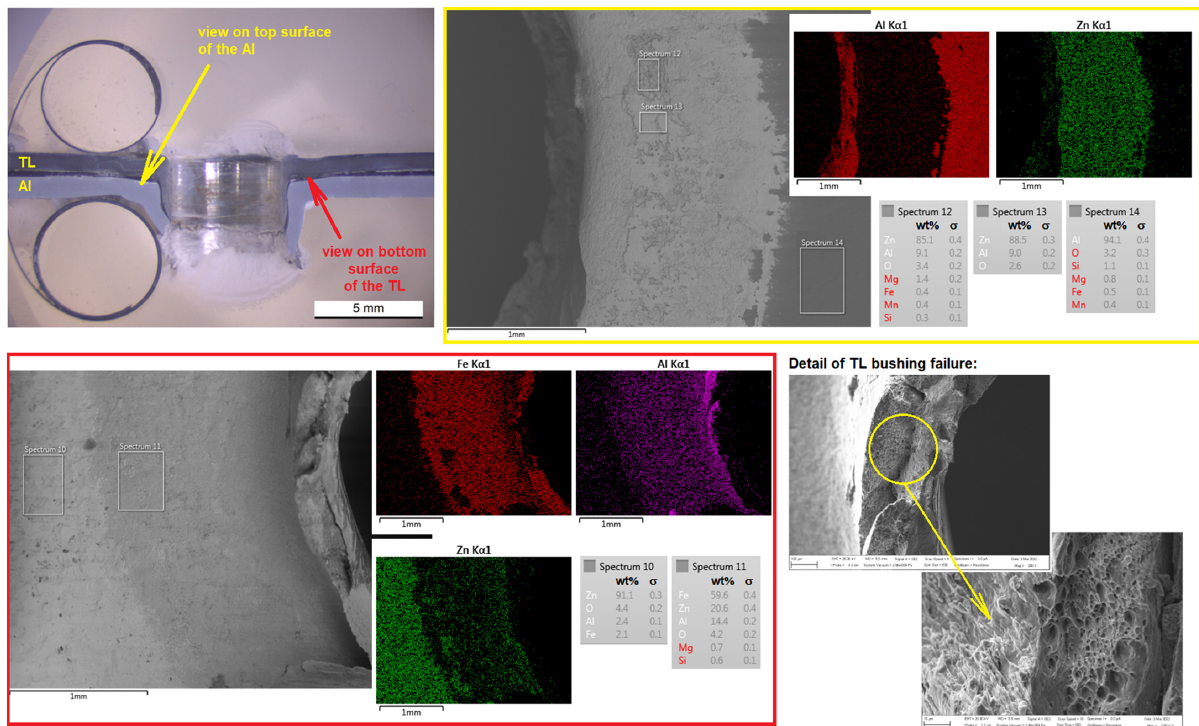
Figure 8. SEM analysis of TL-Al joint, element maps, EDS spectra and fracture surfaces of bushing. The yellow border contains a detailed view on the top surface of the lower material. The red border contains a detailed view on the bottom surface of the upper material.